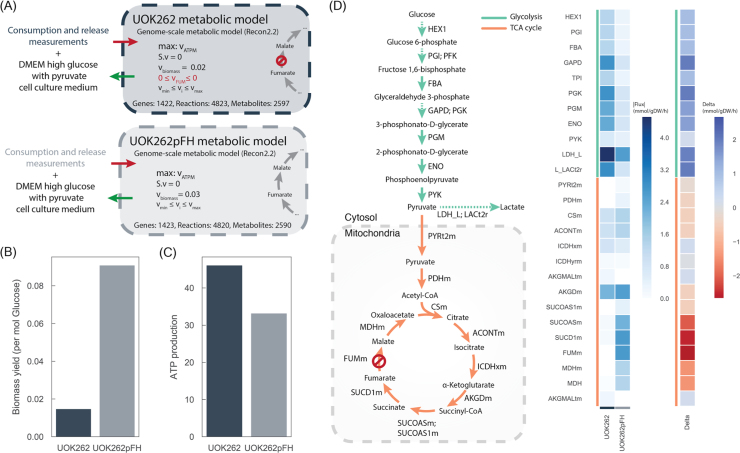
Genome-scale metabolic modelling of UOK262 cell lines. A) Diagram depicting the different constraints used in Recon 2.2 to obtain the condition-specific, UOK262 and UOK262pFH, metabolic models. B) Biomass yield per mol of glucose intake calculated from experimental measurements. C) Maximum ATP production of both models. D) Flux distributions of glycolysis and TCA cycle pathways reactions estimated by maximising ATP production using pFBA.